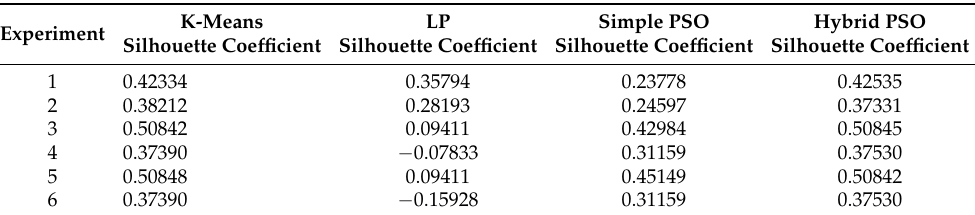
Table 18. The comparison of the silhouette coefficient metric (average), considering the experiments that were performed using the same